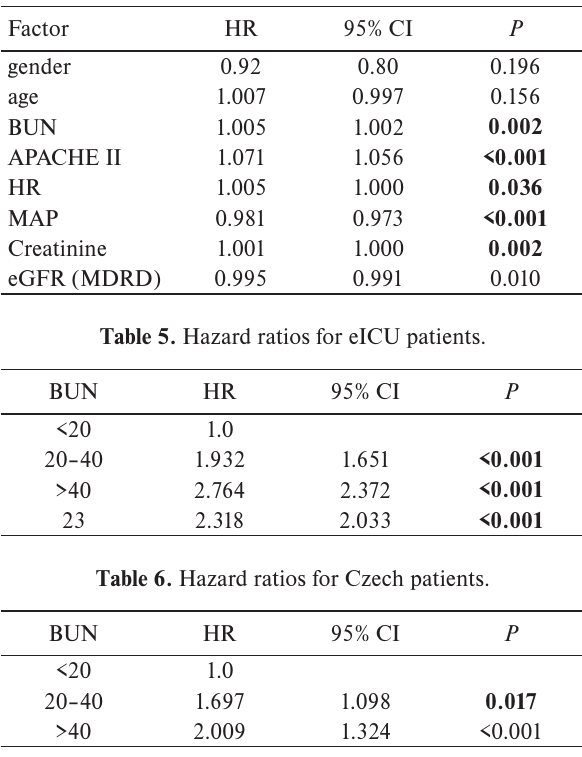
Table 4. Univariate analysis Czech patients.